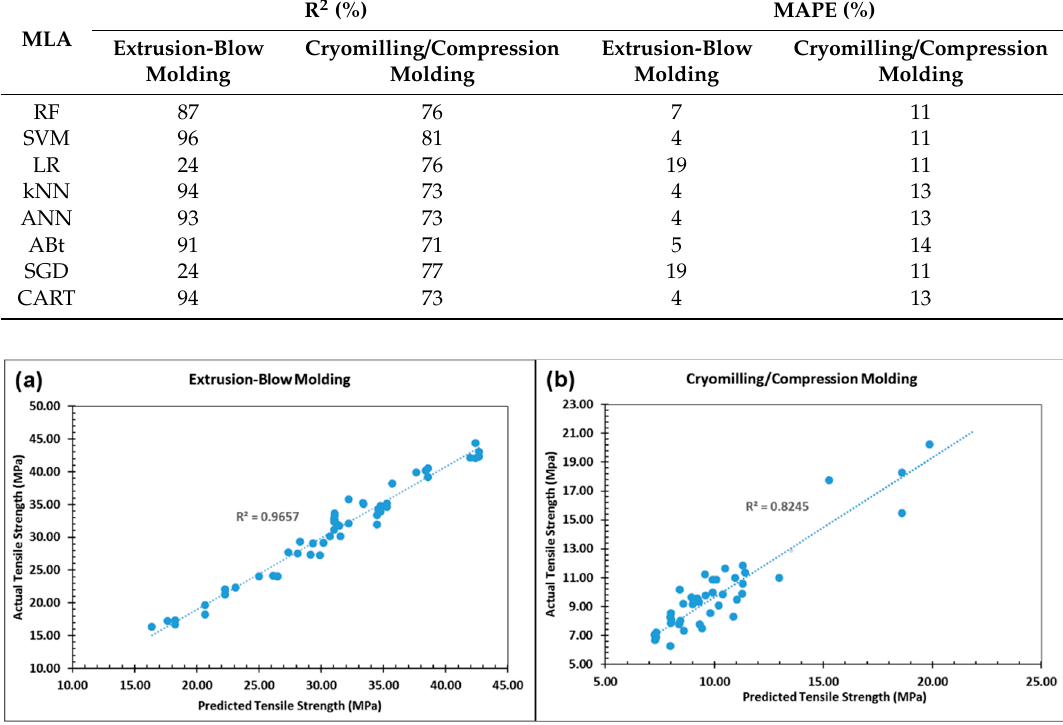
Figure 4. Predicted tensile strength vs. measured tensile stregth by support vector machine (SVM) for: ( a ) extrusion ‐ blow molding, and ( b ) cryomilling/compression molding.